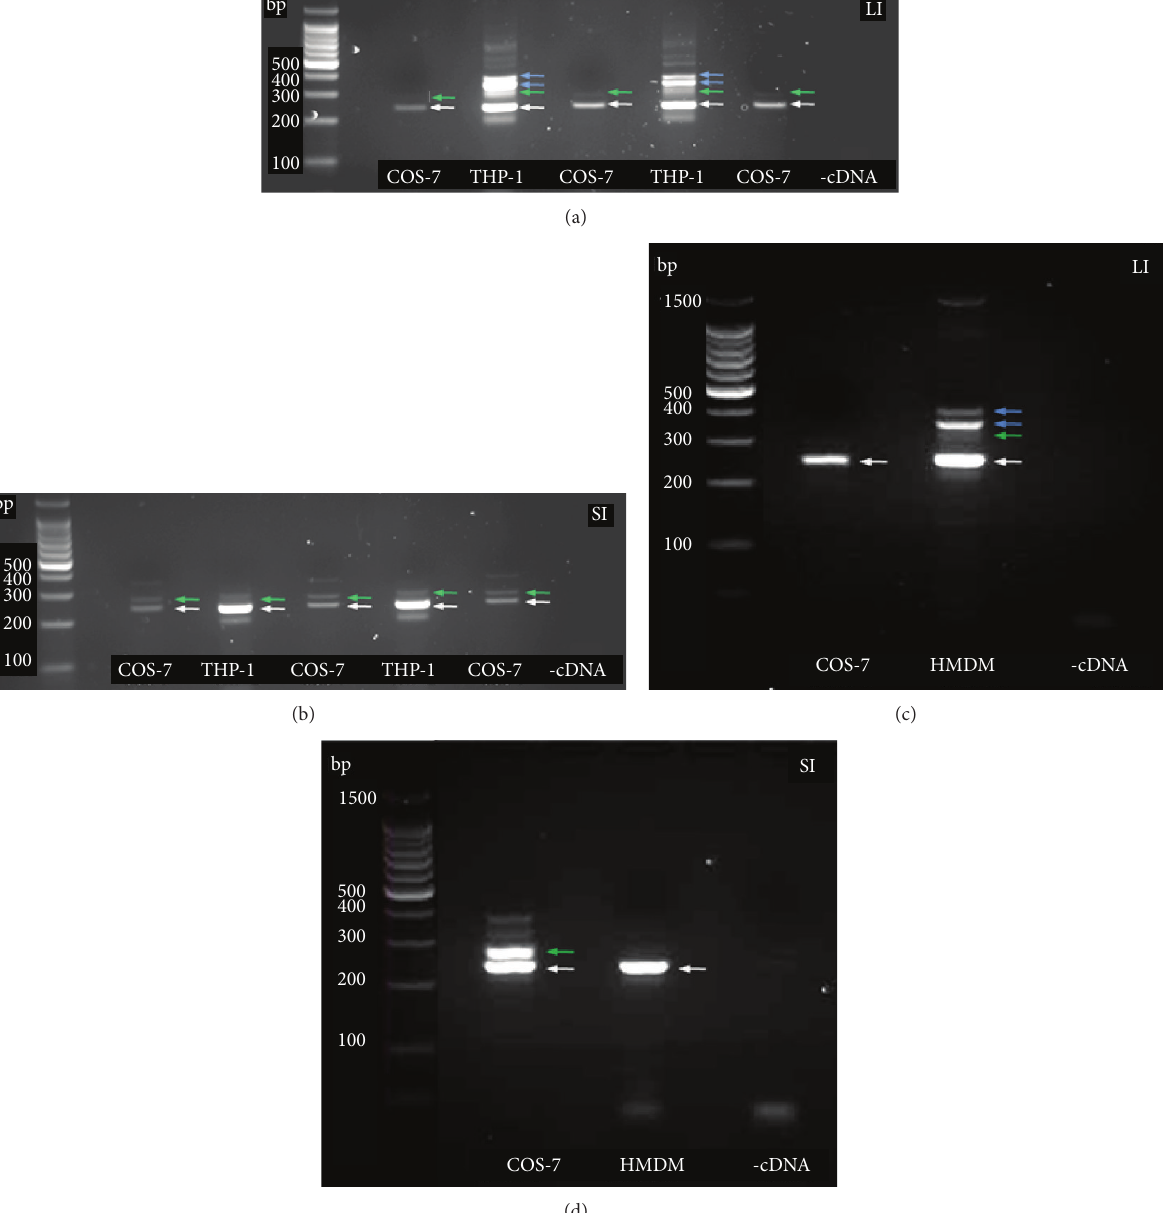
Figure 2: Expression of Myo6 splice variants in THP-1 macrophages and HMDM Total RNA was extracted from THP-1 macrophages (2 separate lysates), HMDM (from two individual donors), and COS-7 cells (3 separate lysates), and PCR was used to amplify the LI and SI of the Myo6 C-terminal tail domain. Products were visualised on a 1.2% agarose gel containing 0.01% ethidium bromide (v: v). (a) Myo6 LI in THP-1 macrophages and COS-7 cells; (b) Myo6 SI in THP-1 macrophages and COS-7 cells; (c) Myo6 LI in HMDM (1 of 2 experiments shown) and COS-7 cells; (d) Myo6 SI in HMDM (1 of 2 shown) and COS-7 cells. White arrows indicate Myo6( − LI), green arrows Myo6(+LI) (a, c) or Myo6(+SI) (b, d), and blue arrows alternatively spliced variants of Myo6